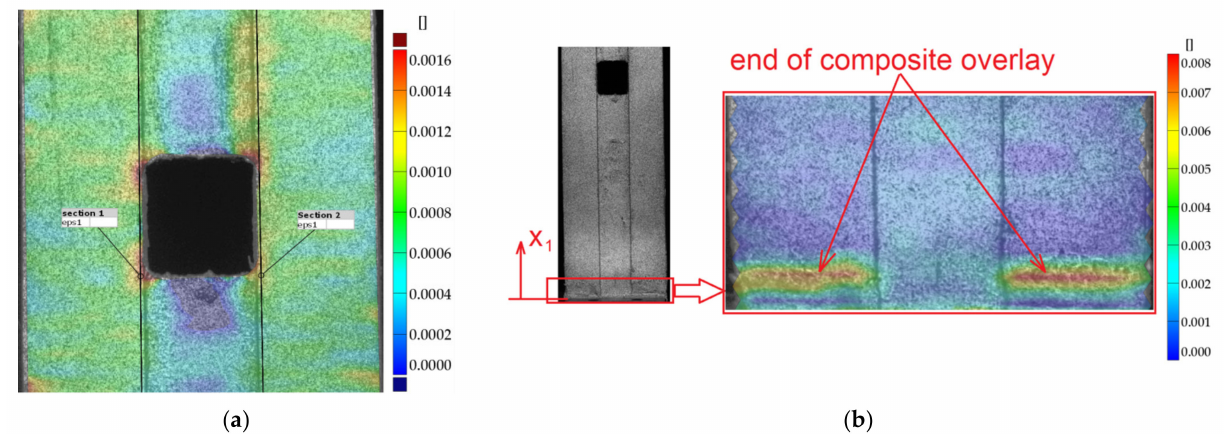
Figure 24. Distribution of surface strain (DIC) for sample no. 22 for maximal load 44.1 kN at